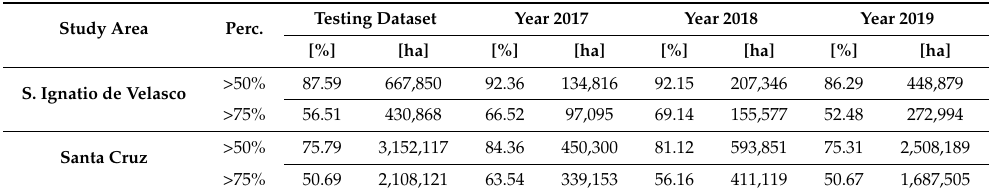
Table 4. Comparison between the predictive performance of the model by quantile ranking range classification for San Ignacio de Velasco and Santa Cruz.